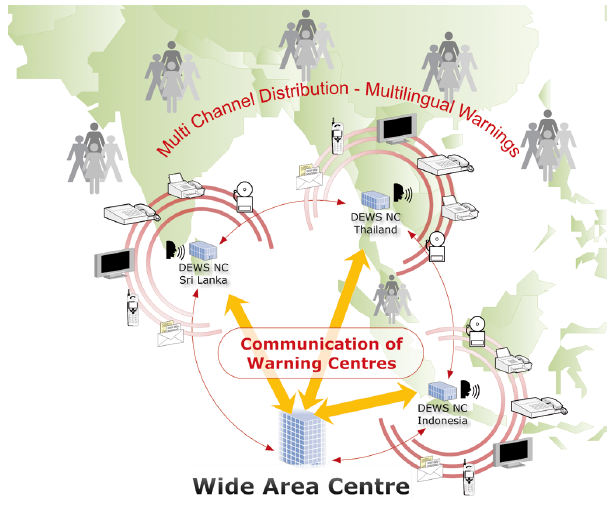
Fig. 7. Centre-to-centre communication in a